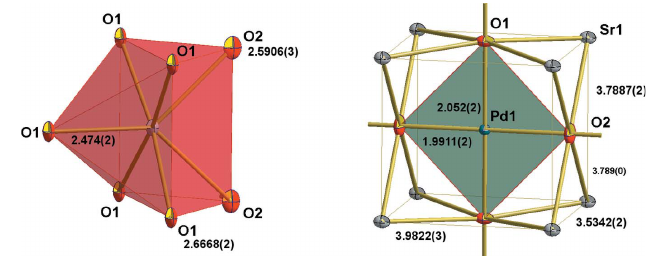
Figure 2 Coordination around the Sr II (left) and Pd II atoms (right). All atoms are drawn with displacement ellipsoids at the 80% probability level. Distances are in A˚ .